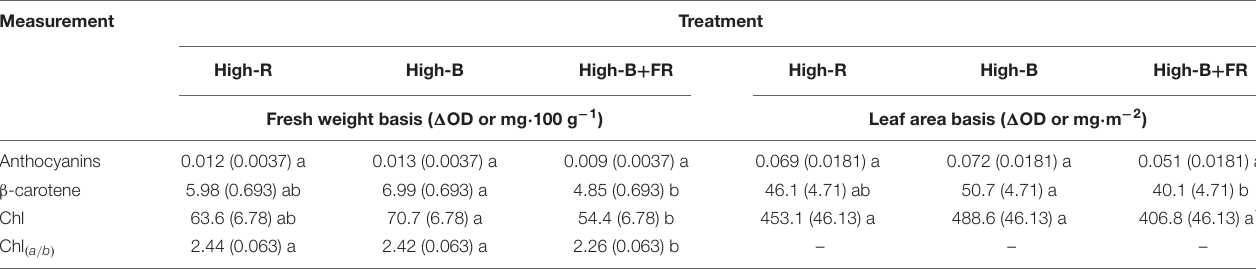
TABLE 3 | Effect of different light treatments (see Table 1 for treatment description) on the levels of anthocyanins, beta-carotene ( β -carotene), chlorophylls (Chl) and ratio of chlorophyll- a to chlorophyll- b [Chl ( a / b ) ] in green romaine lettuce. Measurement